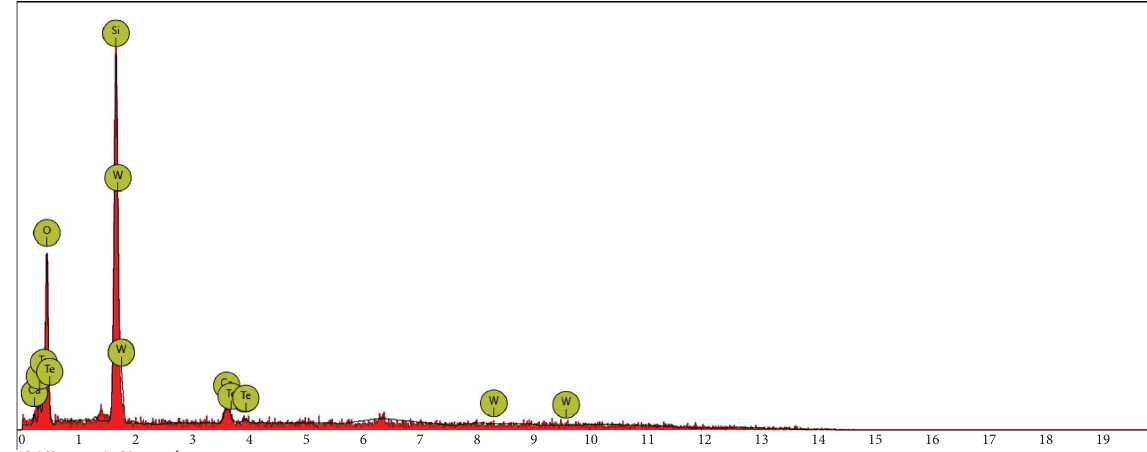
Figure 20: Graphical representation of elements concentration for control sample 800 ° C.